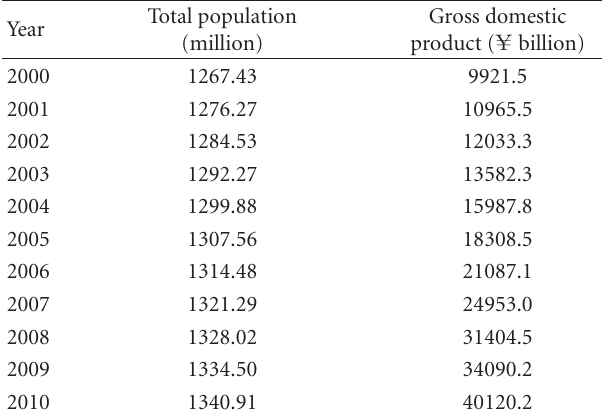
Table 1: Population and GDP information of China during